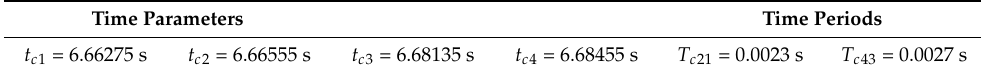
Table 6. Time periods and their parameters according to Figure 21.